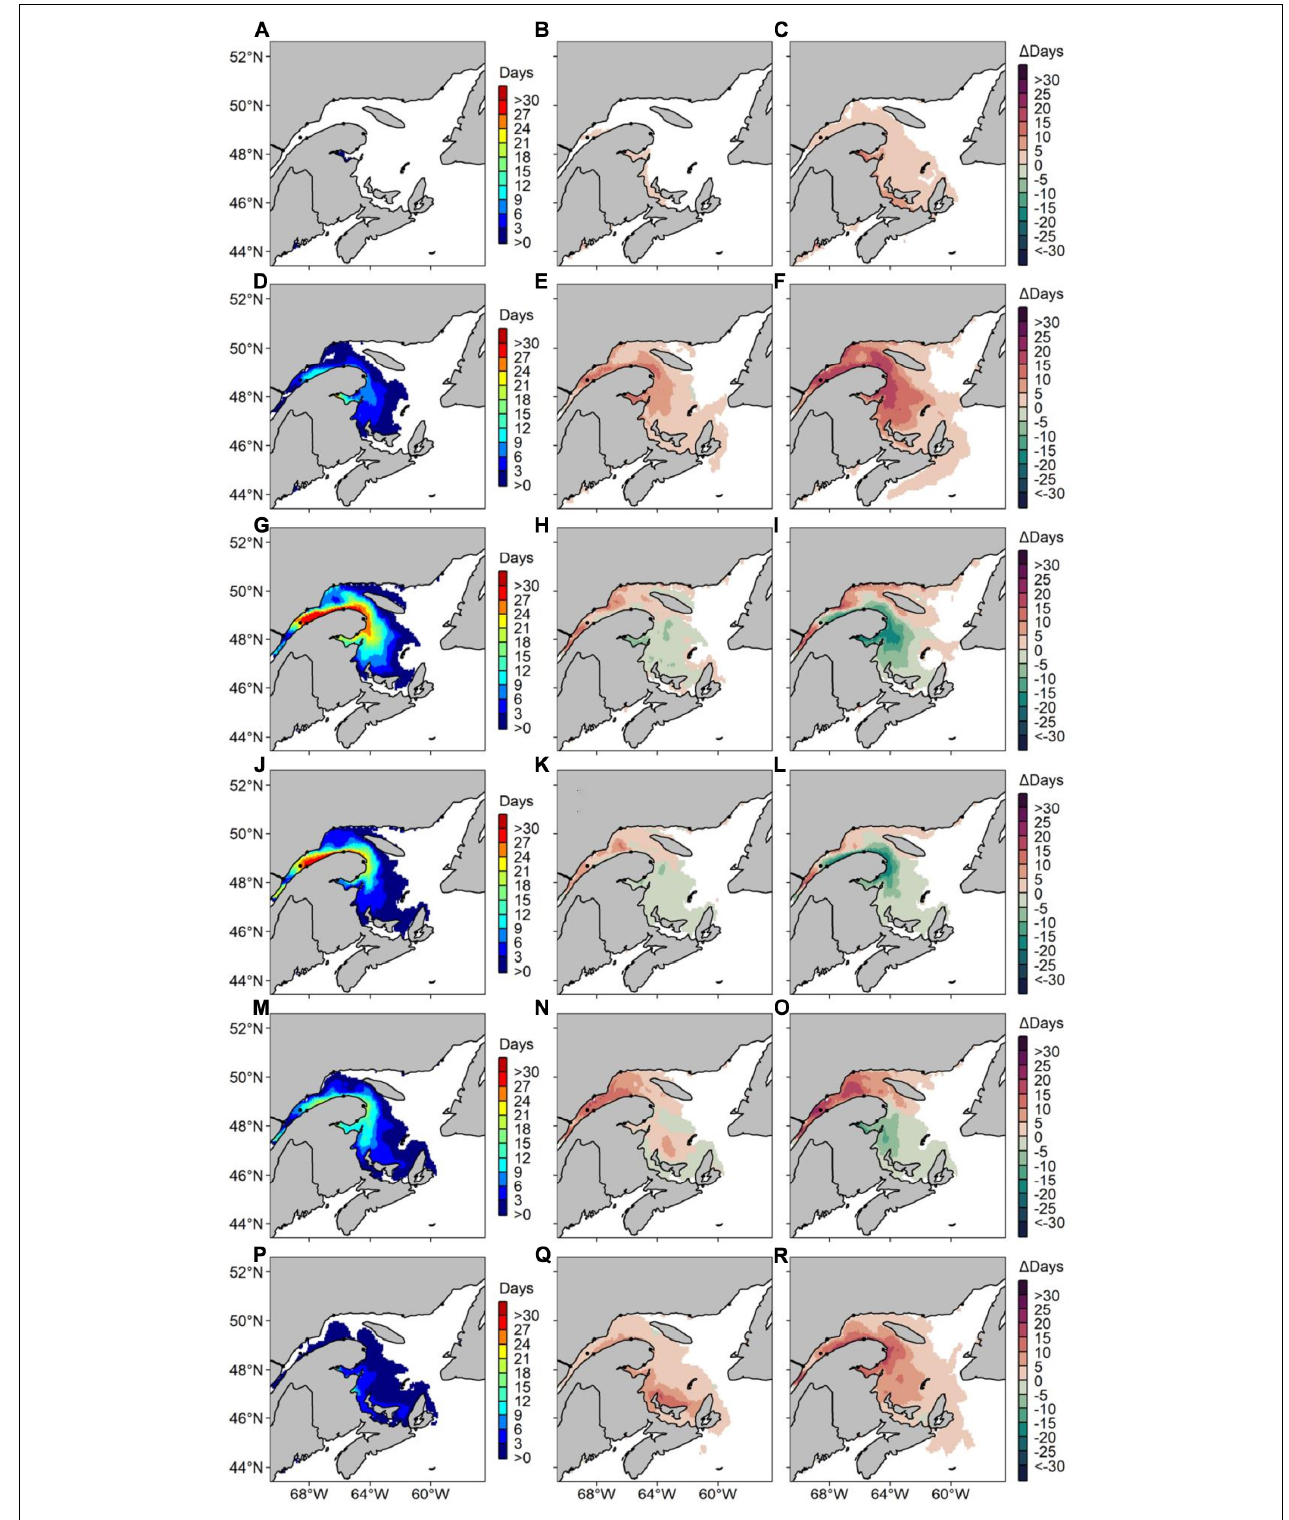
FIGURE 8 | Average number of risk days with Alexandrium catenella ≥ 1000 cells L − 1 along Canada’s East coast under MPI-ESM-LR RCP 8.5 for (A) May 1999-2008, (B) difference in average number of risk days between May 1999–2008 and May 2050–2059 and (C) difference in average number of risk days between May 1999–2008 and May 2090–2099. Same pattern applies for (D–F) June, (G–I) July, (J–L) August, (M–O) September, and (P–R) October.